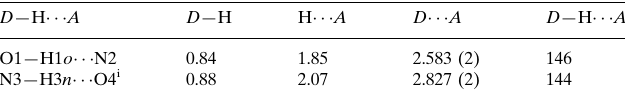
Hydrogen-bond geometry (A˚ , (cid:3)